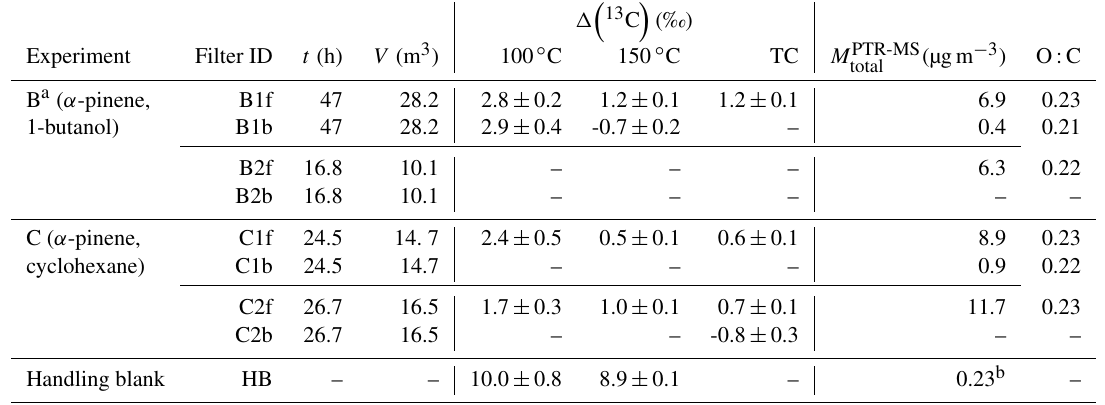
Table 2. Overview of α -pinene ( δ scavenger. Filter IDs are explained in the text. The sampling time, t , and the sampled volume, V , are given. Isotopic data at 100 ◦ C and 150 ◦ C and for total carbon (TC) are given as (cid:49) M PTR-MS , is listed next. The last column lists the measured O:C ratio averaged over all desorption temperatures. total